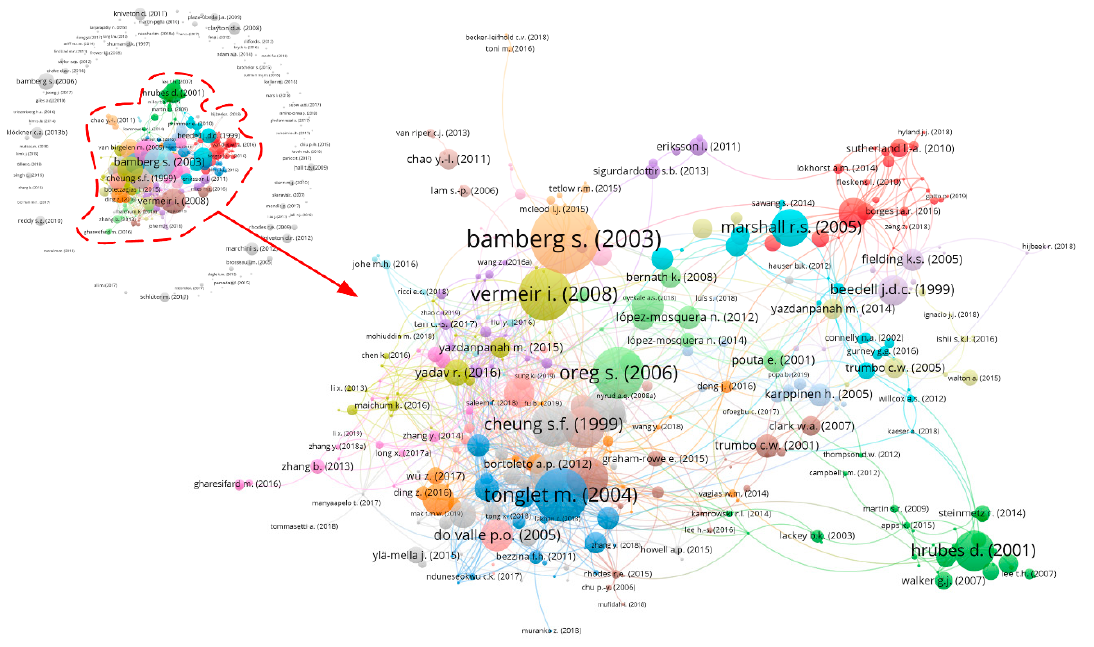
Figure 7. Citation Figure 7. Citation network.